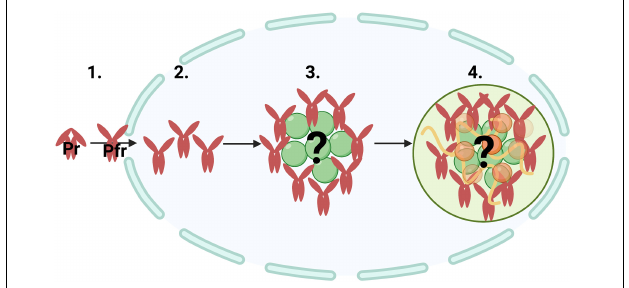
FIGURE 2 | A potential mechanism of photobody biogenesis via nucleation and ultimately through liquid-liquid phase separation. Illustration of (1) inactive phytochrome (Pr) converting to active phytochrome (Pfr) and traveling into the nucleus, (2) nucleation of Pfr, (3) Pfr accumulating around an unknown core structural component or ‘seed,’ and (4) localizing into a single photobody. Phytochrome photobodies may be undergoing an initial nucleation step, which can initiate protein phase transitions, followed by more complex molecular interactions with other proteins (orange and green spheres) and nucleic acids (yellow curved